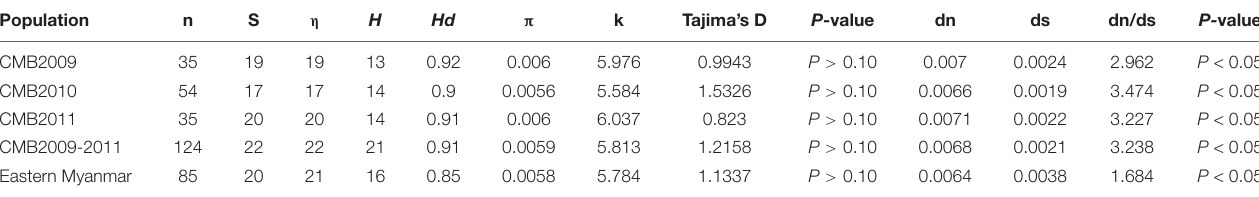
FIGURE 2 | Sequence and polymorphism of PvDBP-II in P. vivax CMB isolates. (A) The structure of Plasmodium vivax Duffy binding protein. (B) The changes in amino acid sequences. Polymorphic amino acids are listed for each haplotype. Amino acid residues identical to those of the reference sequence, SaI I (DQ156512), are marked in yellow. The dimorphic amino acid changes are marked in blue. Total number of sequences for each haplotype is listed in right panel. (C) Frequencies of amino acid changes found in PvDBP-II among CMB and eastern Myanmar isolates. TABLE 1 | Genetic diversity and natural selection of pvdbp -II in China-Myanmar border and eastern Myanmar